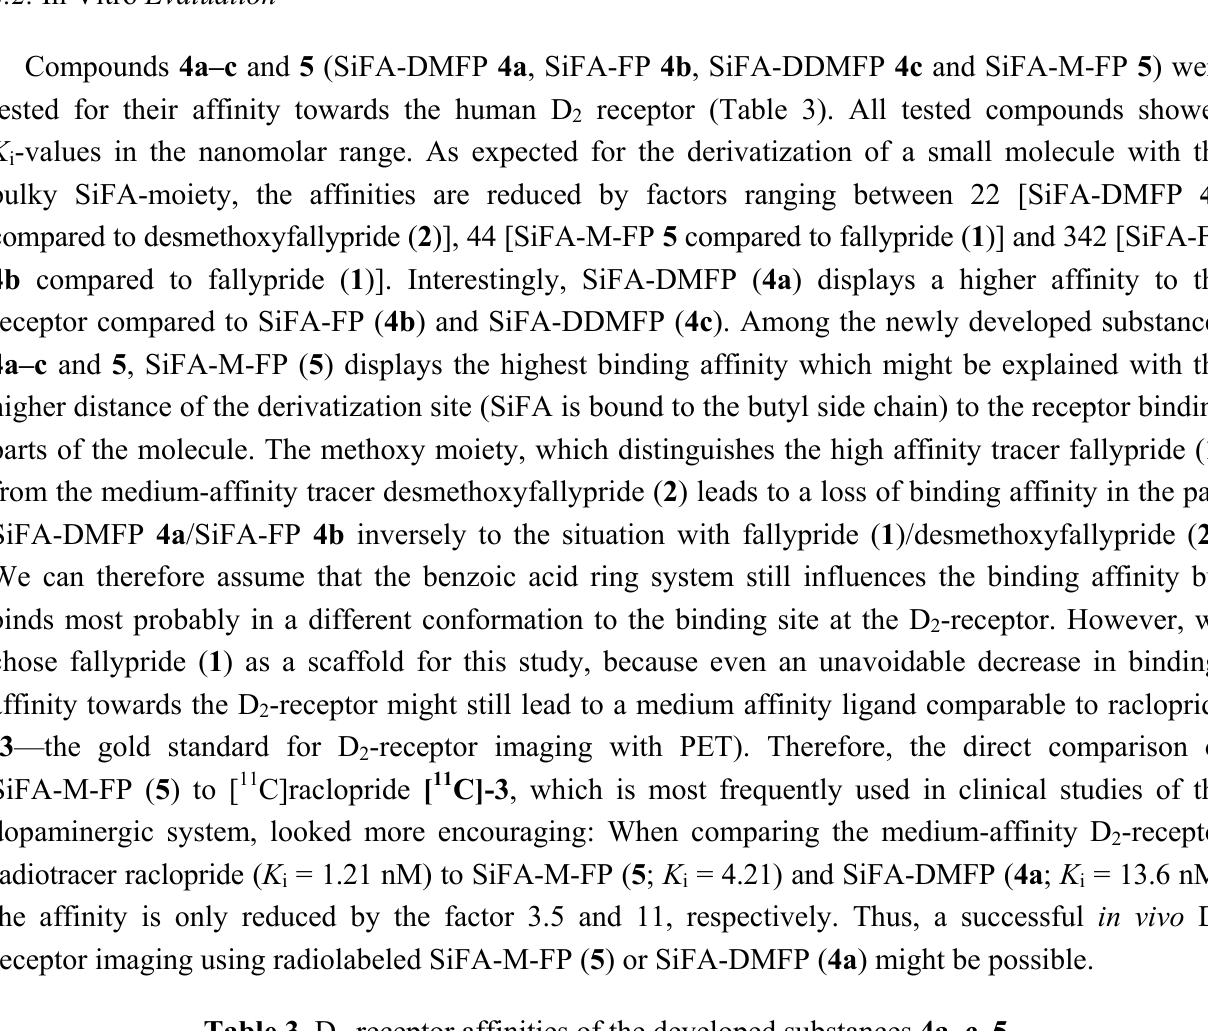
-receptor affinities of the developed substances 4a–c , 5 Table 3. D 2